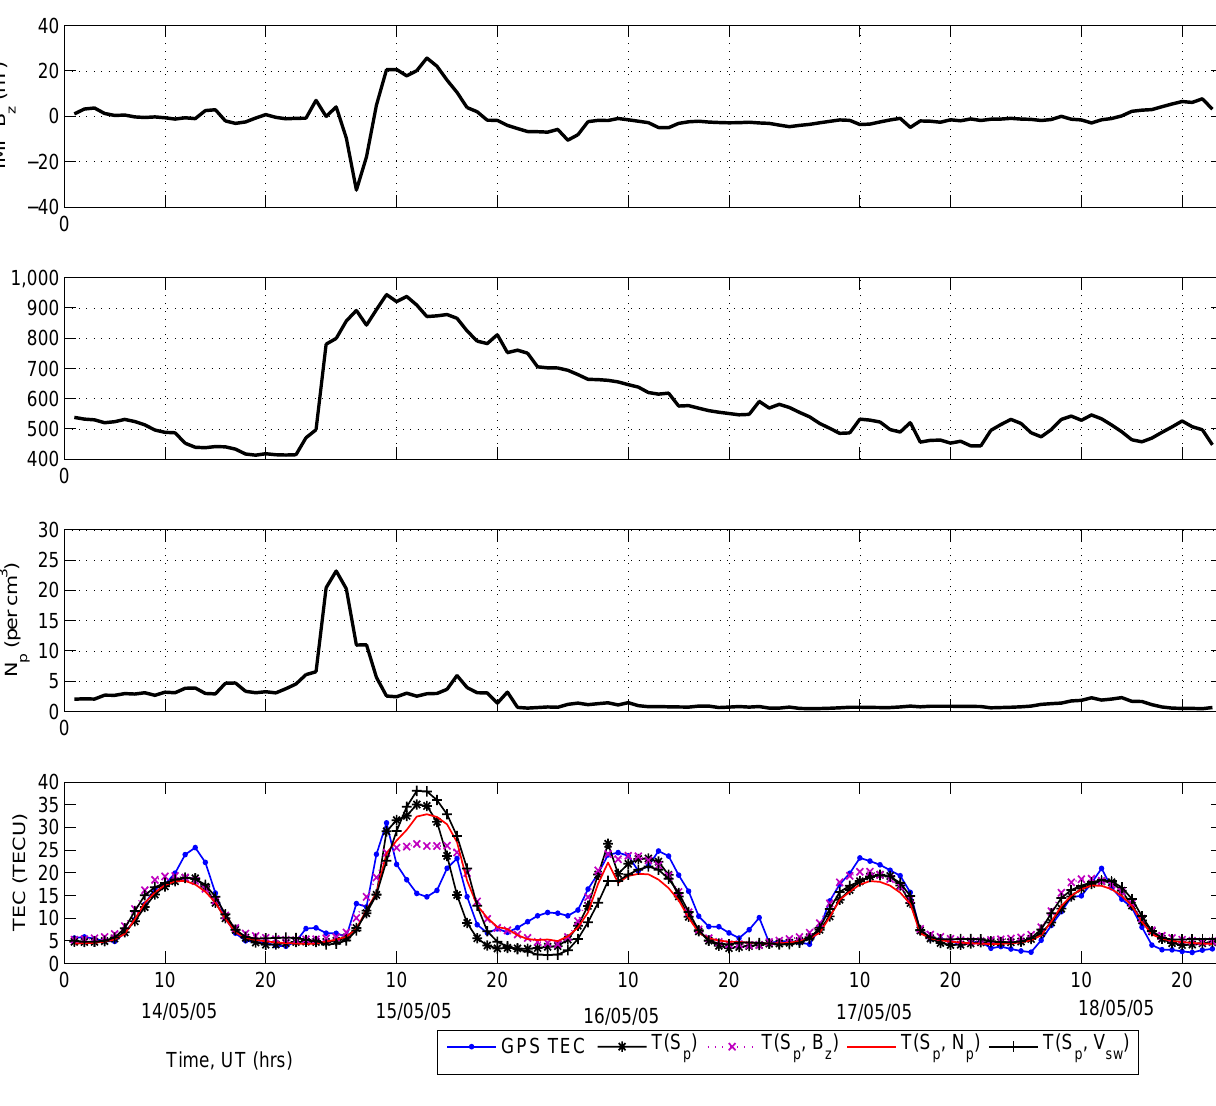
and V sw over an equatorial station, Ootacamund (11.4 ◦